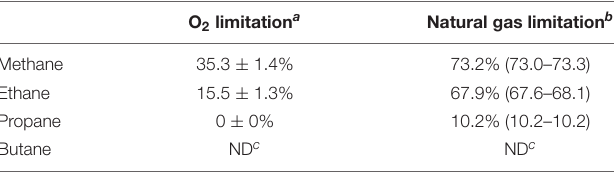
TABLE 1 | Consumption of methane, ethane, propane, and butane by M. fumariolicum SolV during O 2 and natural gas